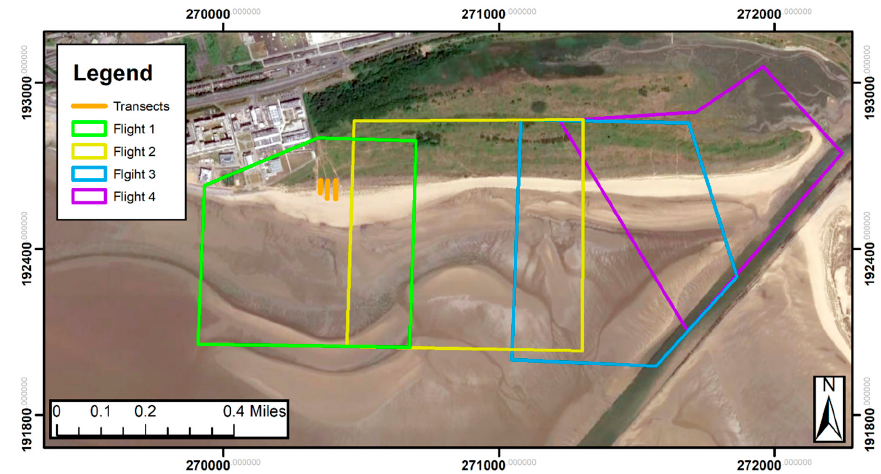
Figure 3. A map showing the four overlapping flight areas used to cover the dune system and also the location of the three transects used to test vegetation removal method.